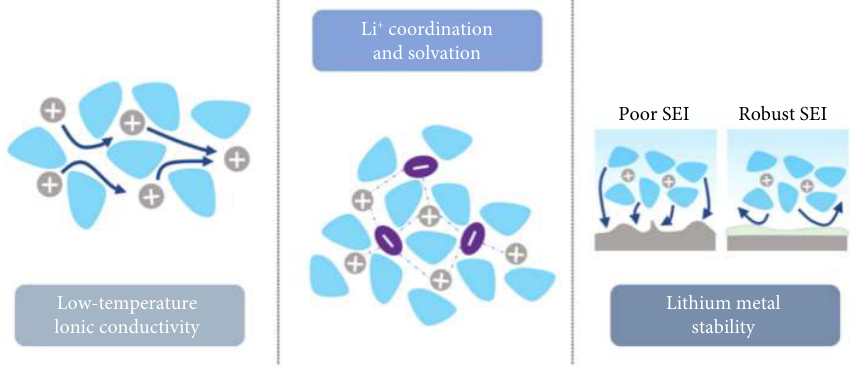
Fig. 3 The role of electrolyte design on the low-temperature chemistry of Li metal anodes including regulating the ionic conductivity of electrolyte, the solva- tion structure of Li ions, and the properties of SEI films (reprinted with permission from Ref. [21], © 2020